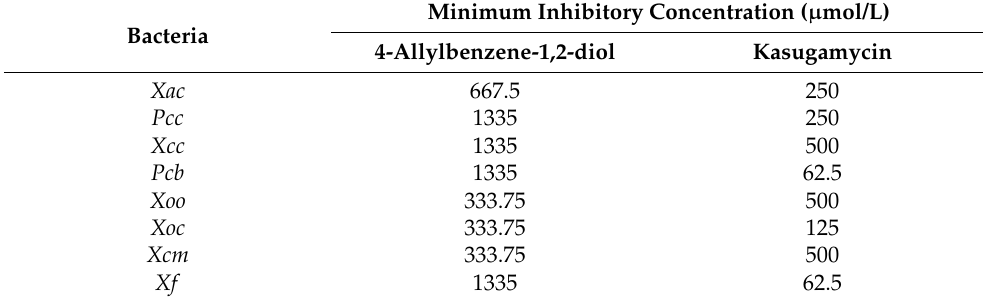
Table 2. Minimum inhibitory concentrations of 4-allylbenzene-1,2-diol against phytopathogenic bacteria.